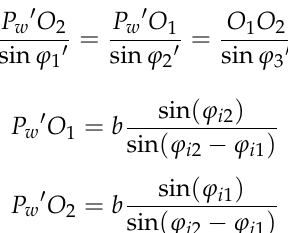
Figure 10. Geometric simplification of binocular stereo panoramic vision. The horizontal distance between two single-view panoramic vision systems is b , and there is a world point P w . In the panoramic vision systems, the world coordinates of camera_left and camera_right are P w 1 = ( r w 1 ; ϕ w 1 ; z w 1 ) , P w 2 = ( r w 2 ; ϕ w 2 ; z w 2 ) . The projection points on the camera_left hyperboloid and camera_right hyperboloid are P h 1 , P h 2 . The projection points on the right panoramic image plane and camera_left panoramic image plane are P i 1 , P i 2 , r p is the distance between P w and O 1 O 2 , The intersection points of P w O 1 , P w O 2 and left hyperboloid, right hyperboloid are P h P h 1 , 2 .The plane Π is the plane of the x -axis of the rectangular coordinate systems and perpendicular to the z -axis. The projection of point P w on the Π plane is P w (cid:48) . The intersection points of P w O 1 and camera_left hyperboloid mirror is P h 1 (cid:48) .The intersection points of P w O 2 and camera_ right hyperboloid mirror is P h 2 (cid:48) .The angle between P w (cid:48) P h 1 (cid:48) , P w (cid:48) P h 2 (cid:48) and X axis is ϕ 1 (cid:48) , ϕ 2 (cid:48) . Because ϕ where is no change after the nonlinear transformation of hyperboloid mirror, and the number of projection points in panoramic image is small, then the value of ϕ i is equal to that of the environment point ϕ Value. And plane P w (cid:48) O 1 P w is perpendicular to the plane Π , so P w (cid:48) , P w and P i are same value ( ϕ 1 = ϕ 1 (cid:48) = ϕ i 1 ; ϕ 2 = ϕ 2 (cid:48) = ϕ i 2 ). In 𝛥𝑃 𝑤′ 𝑂 1 𝑂 2 , according to the sine theorem: